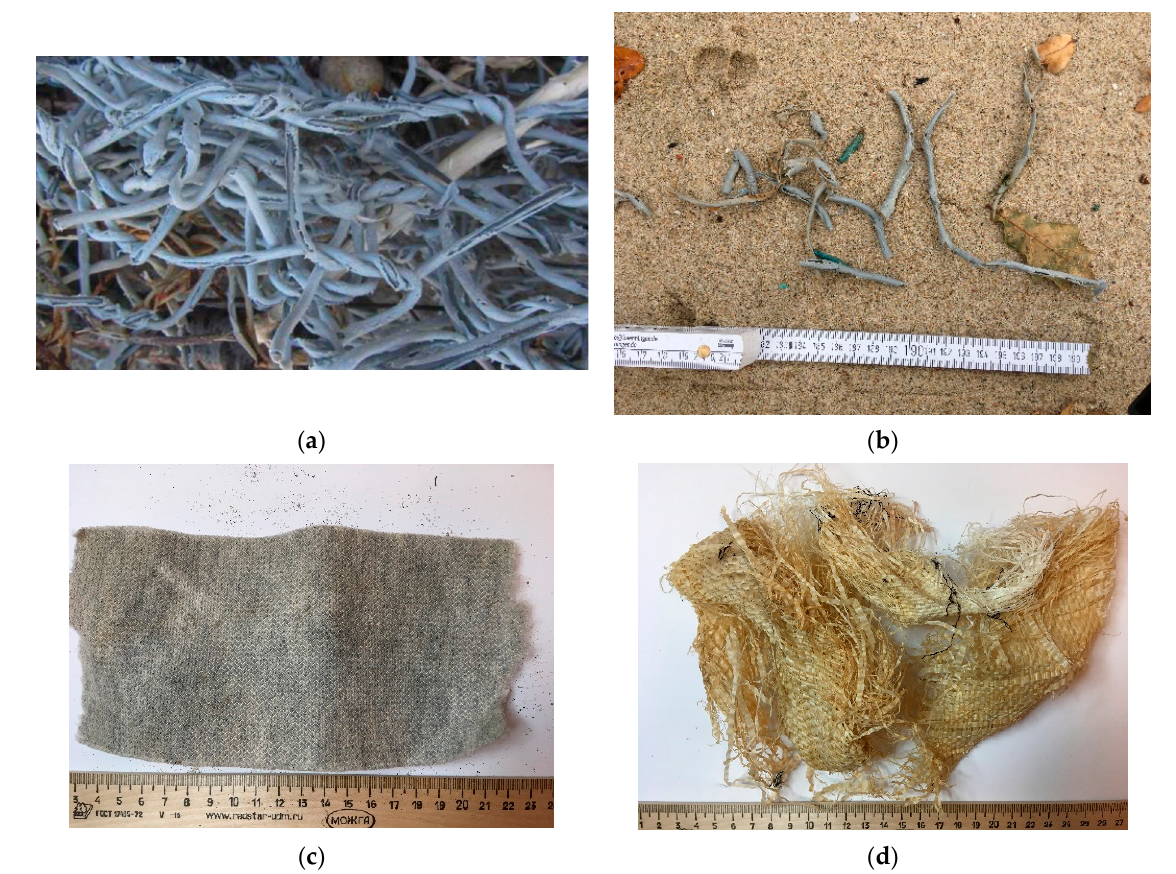
Figure 3. Photographs of samples collected during the field study: ( a ) + ( b ): aged plastic coating of wires in gabions’ ( c ) debris from geocell; ( d ): debris from big bag. Table 3. Occurrence of residues of geosynthetic materials and other large debris in pieces per 1 running kilometer of the coastline in various morphodynamic segments of the Baltic shore of the Kaliningrad Oblast by surveys in 2018. Morphodynamic Segments of the Shore Geotextile Gabion Coating “Big Bags” Geocell Vistula Spit 0.01 0.13 0.25 0 Western shore of the Sambian Peninsula 0 0.18 0.15 0 Northern shore of the Sambian Peninsula 2.90 9.38 5.98 0.13 Curonian Spit 0.24 1.97 4.26